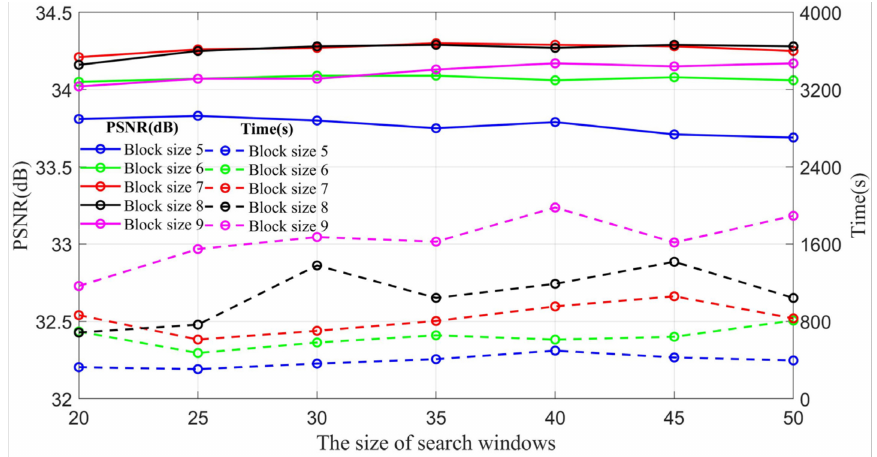
Figure 5. The PSNR and Time for “House” with different block sizes and different search win- dows sizes.